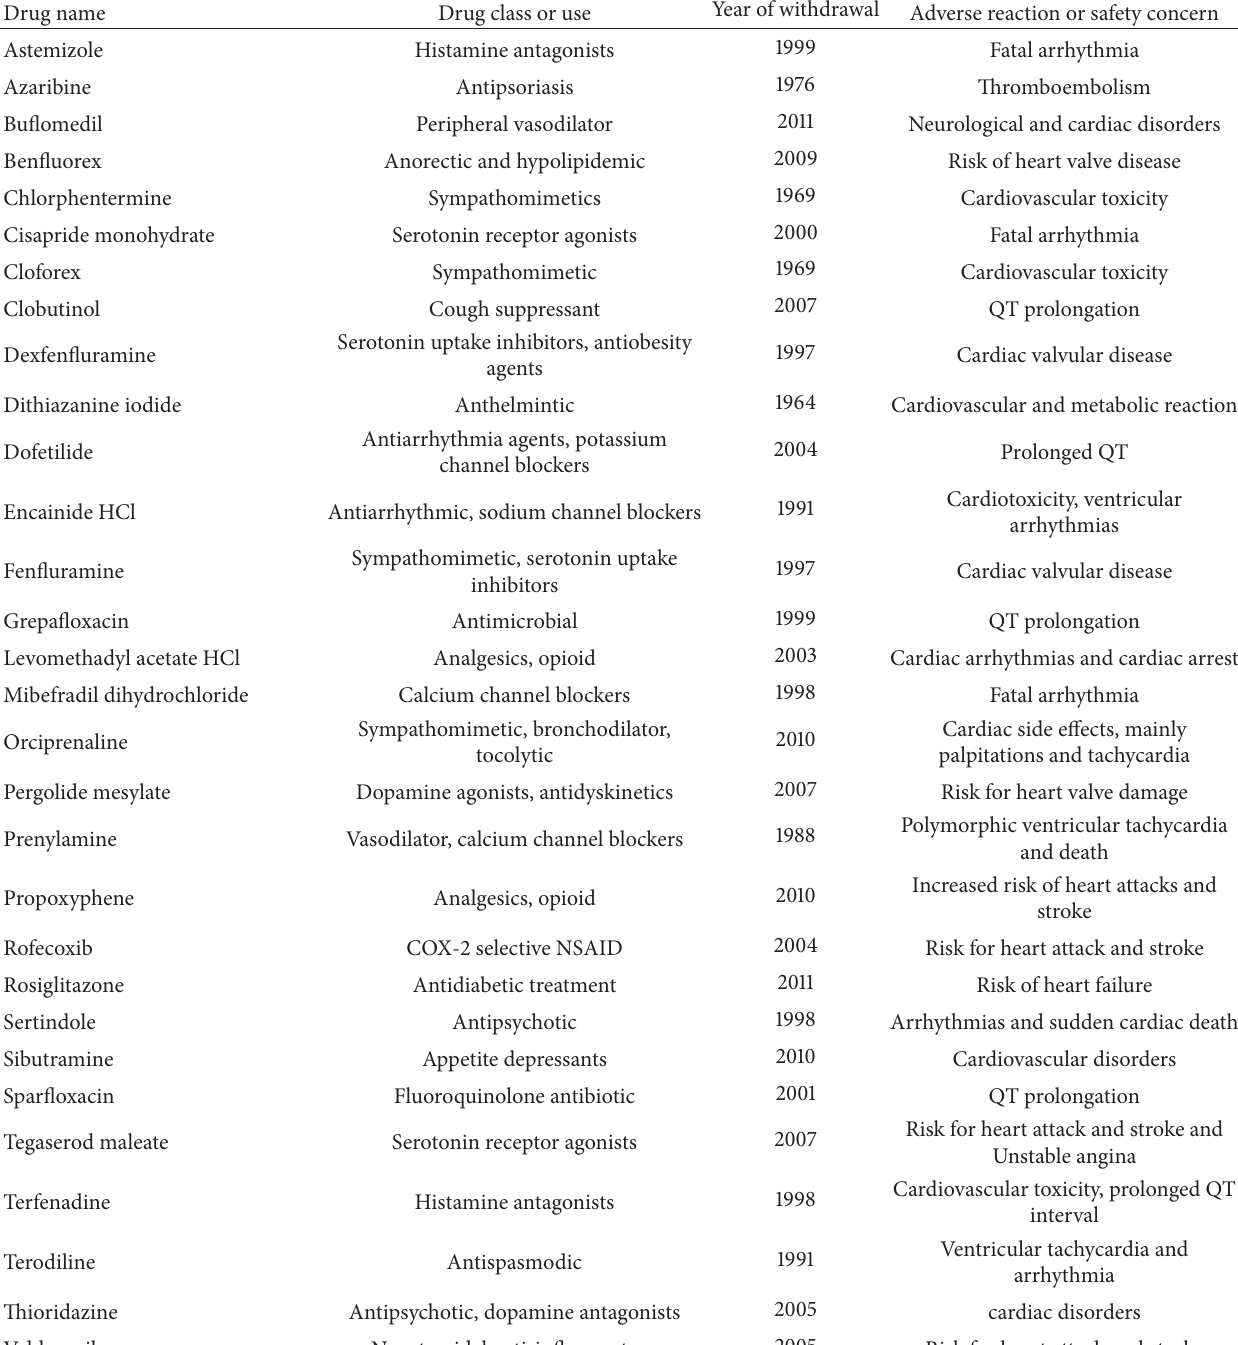
Table 2: List of drugs withdrawn from the market for safety reasons because of severe cardiovascular